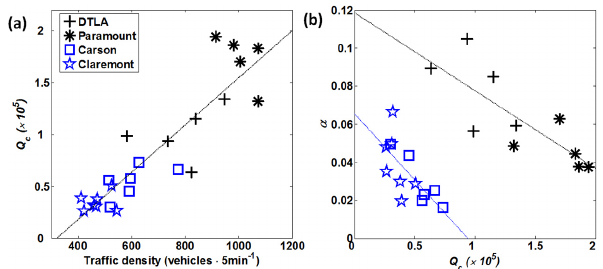
Figure 9. (a) Emission parameter, Q c as a function of traffic density (vehicles5min − 1 ) in four sampling sites, and (b) α variations as a function of Q c . Dotted line represents a linear fit to all data points in the plot: (a) Q c = 227.7 × (Traffic flow) − 7.3 × 10 4 ( R 2 = 0.80) and (b) α =− 4.1 × 10 − 7 · Q c + 0.12 ( R 2 = 0.63 for overpass free- ways) and α = -6.9 × 10 − 7 · Q c + 0.065 ( R 2 = 0.51 for underpass